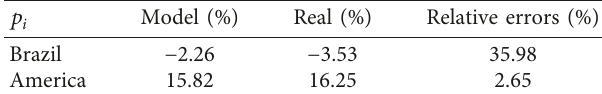
Table 5: Prediction for price